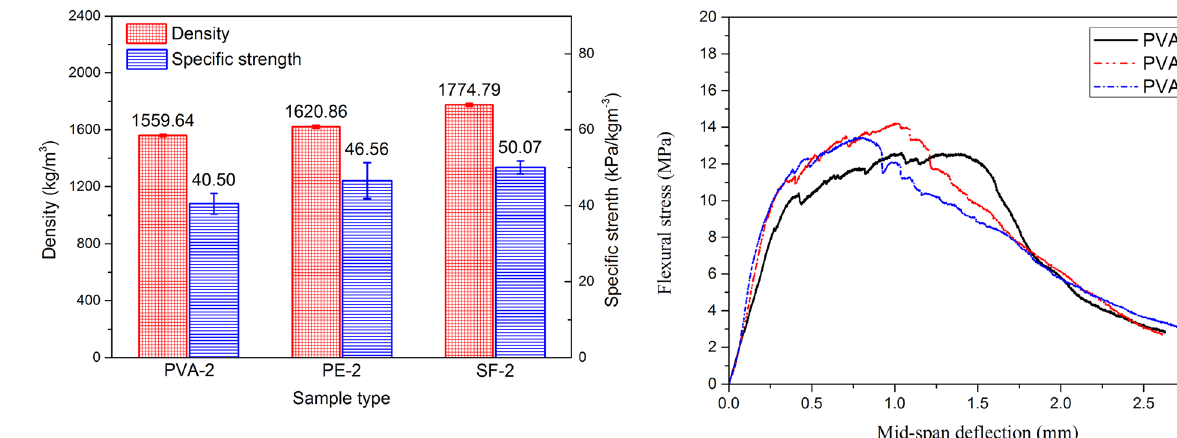
Figure 7: The density and speci fi c strength of lightweight cement - based composites.